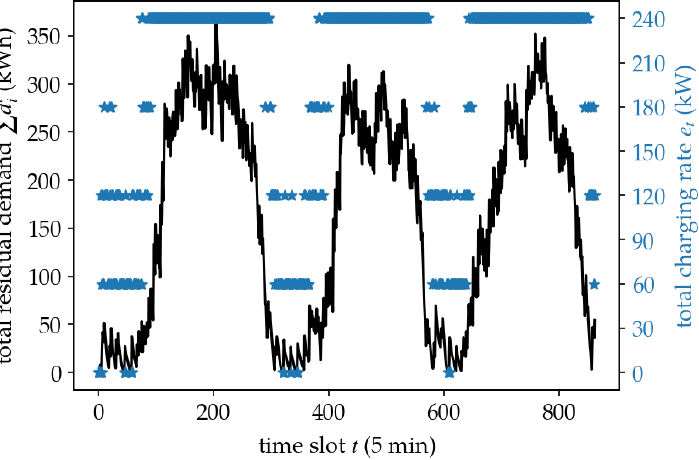
Figure 20. Total residual demand vs. total charging rate (three-day episode duration).